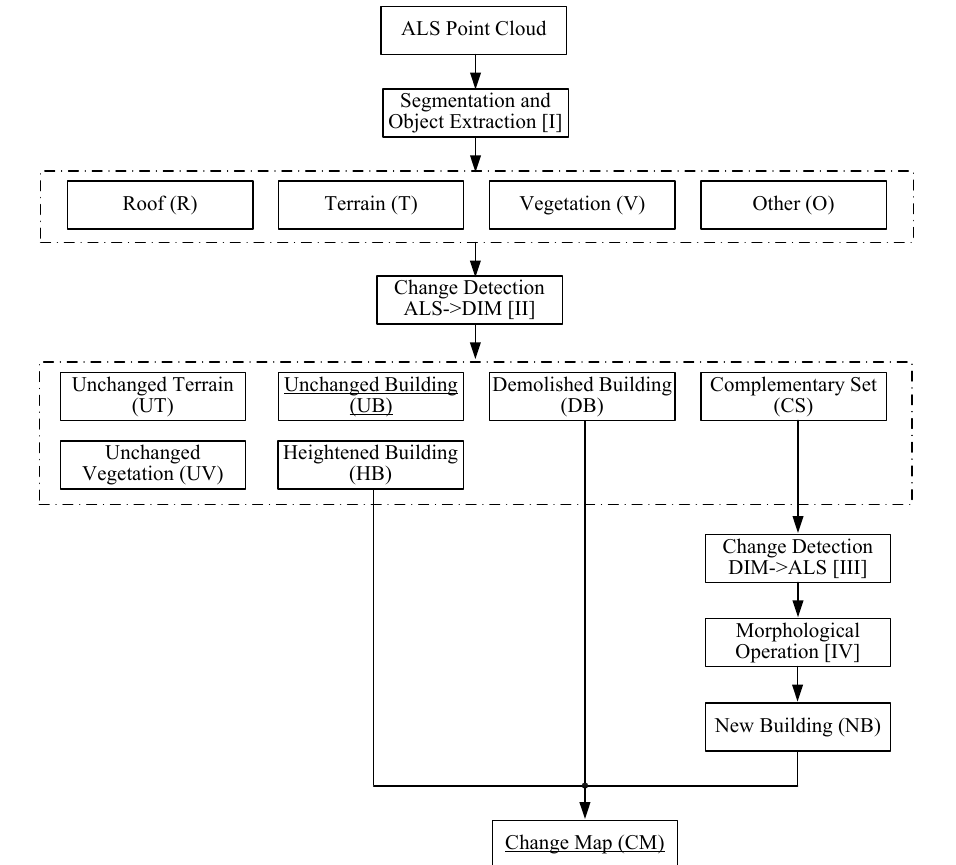
Figure 2. Overview of proposed method. R , T , V , UT , UB etc. in the round brackets indicate products. I, II, III and IV in the square brackets indicate four steps. The final products are underlined: unchanged building ( UB ) and change map ( CM ).